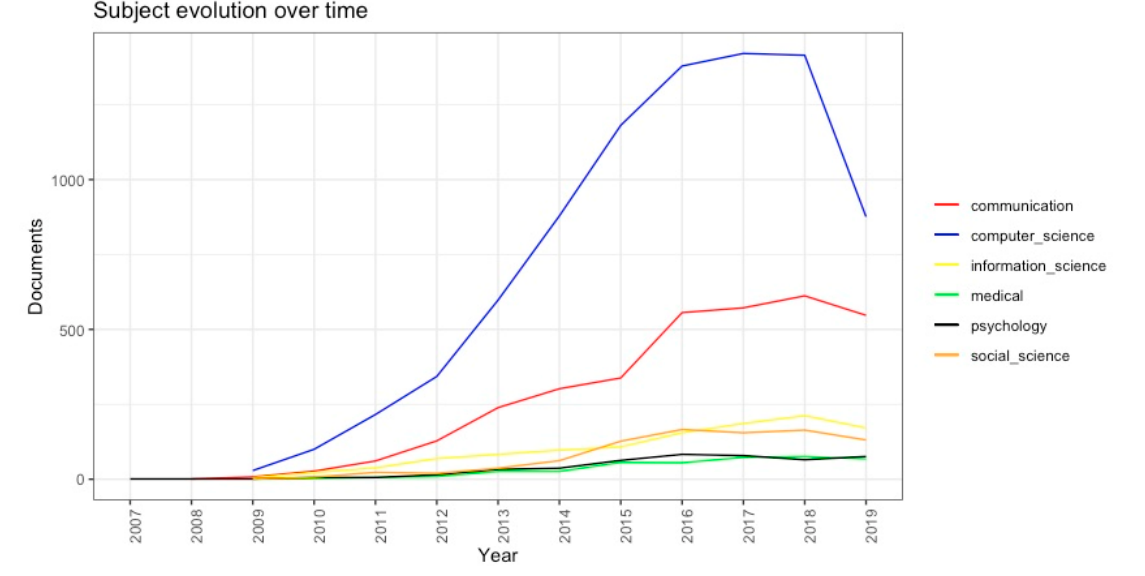
Figure 3. Subject evolution over time.